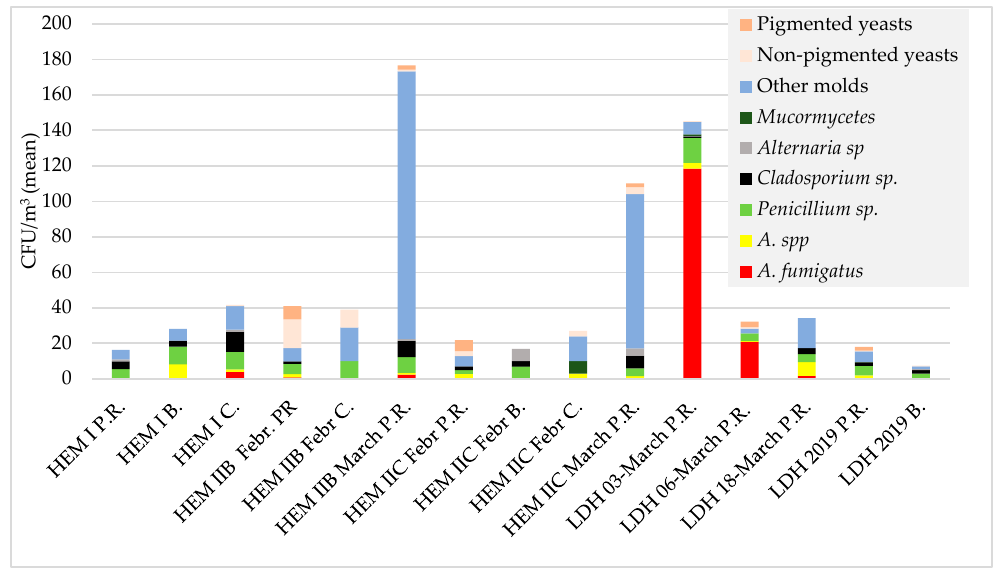
Figure 2. Species distribution in air samples from hematology units (HEM I, HEM II B, HEM IIC) and hospitals for lung diseases (LDH) wards. The graph shows mean CFU/m 3 values for each fungal species/morphotype. For HEM I ward, the results obtained in December 2014 and April 2015 are summarized together; for HEM IIB and HEM IIC, the results obtained in February 2015 and March 2015 are presented separately. The following abbreviations are used: P.R.—patient rooms, B.—bathrooms, C.—corridors. The term “other molds” includes hyalohyphomycetous fungi, different from the other listed genera. Among “other molds” isolated in March from HEM IIB and HEM